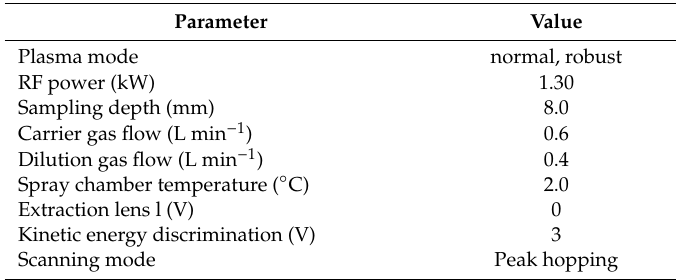
Table 2. Instrumental parameters of ICP-MS